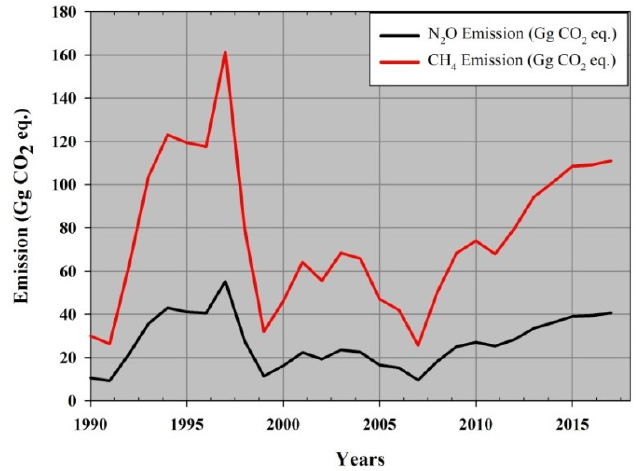
Figure 8. The value of CO 2 eq. for the emission of CH 4 and N 2 O from the use of crude oil, fuel oil, and natural gas in electricity generation in Iraq.